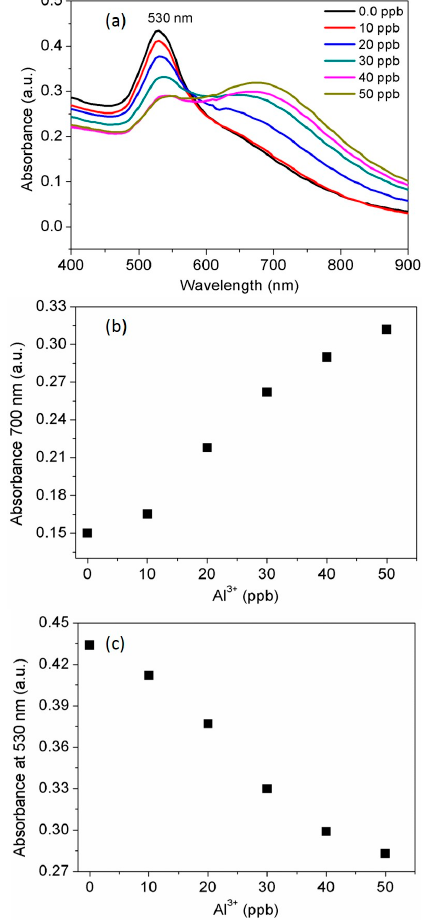
Figure 4. ( a ) The spectral response of AuNPs in the presence of increasing amounts of Al 3+ at room temperature; ( b ) A linear fit curve of absorbance intensity at 700 nm vs. Al 3+ concentration; ( c ) A linear fit curve of the absorbance intensity at 530 nm vs. Al 3+ concentration.